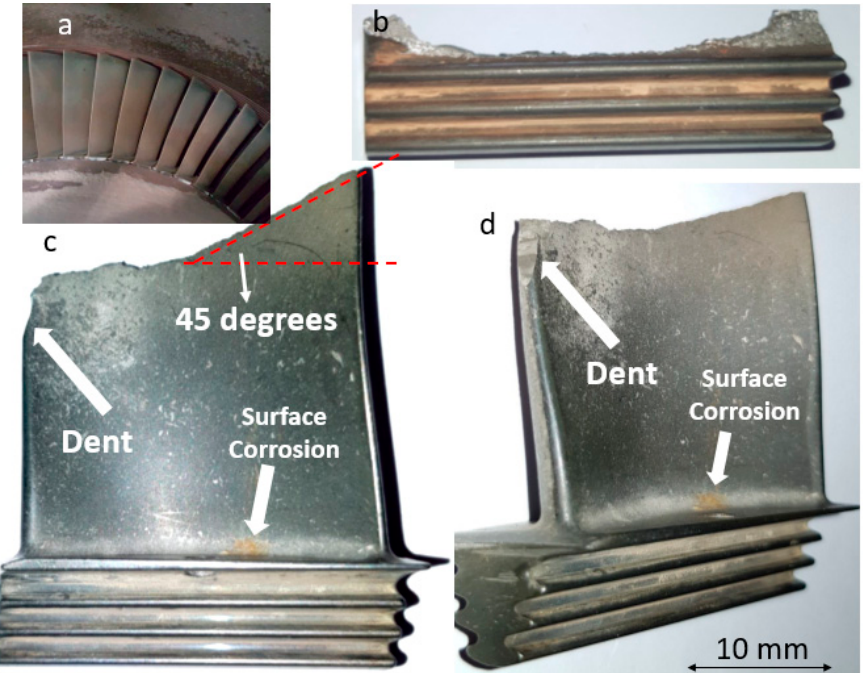
Figure 1. Visual observation of broken blade, ( a ) and overview of blades in the assembled condition, ( b ) failed blade from the root, and ( c , d ) broken blade from the airfoil.